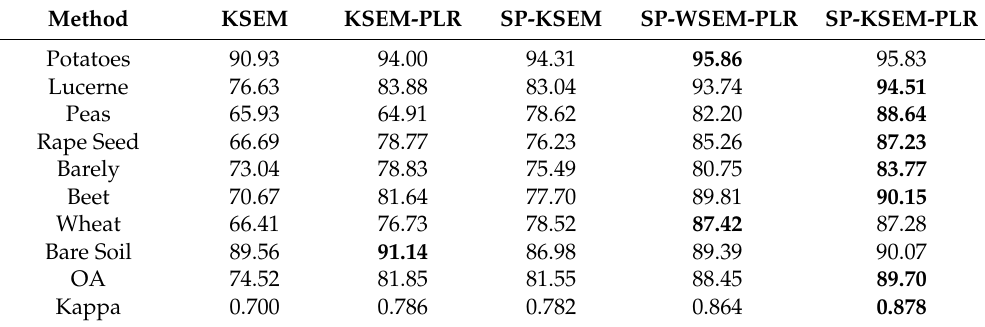
Table 3. Classification accuracy measures of the AIRSAR